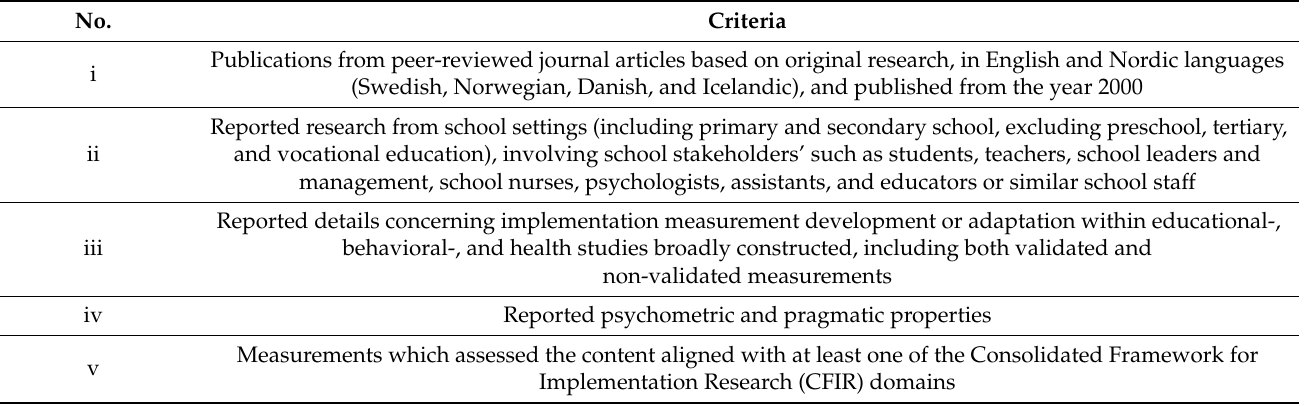
Table 1. Eligibility